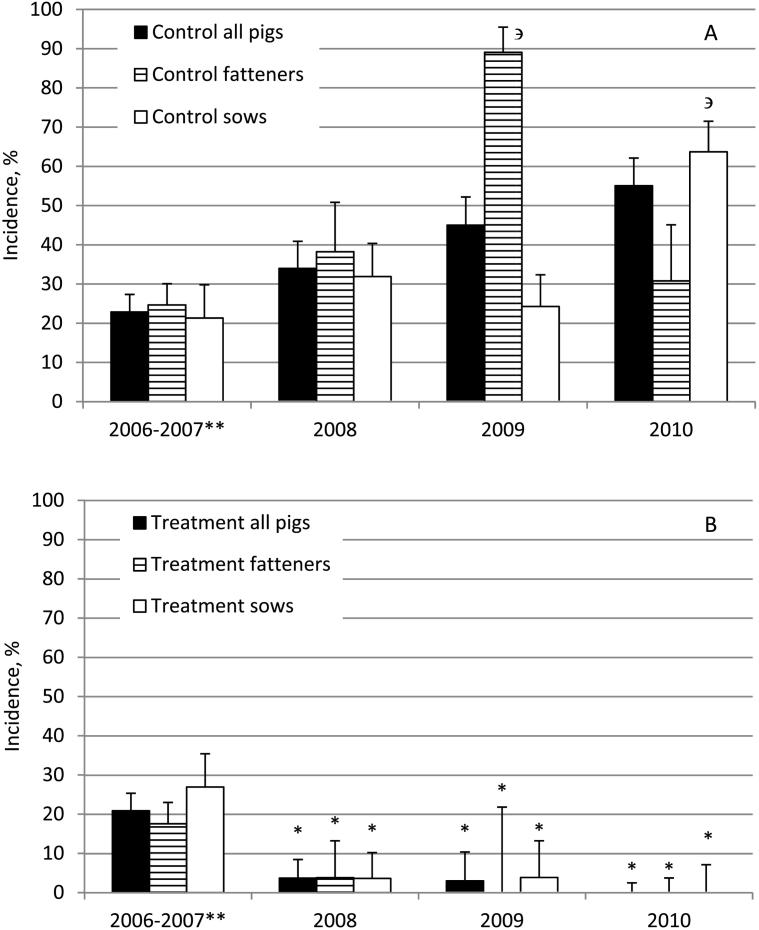
The annual incidence of cystic echinococcosis in all pigs investigated, in fatteners and in sows from control areas (A) and areas with anthelmintic intervention starting in December 2006 (B) according to post-mortem examination of carcasses from pigs slaughtered during the whole year. *significant reduction as compared to respective pigs from control areas in the same year (p < 0.05) or other group of pigs in the same year ∋ (p < 0.05); ** data collected in period between November 2006 and December 2007.